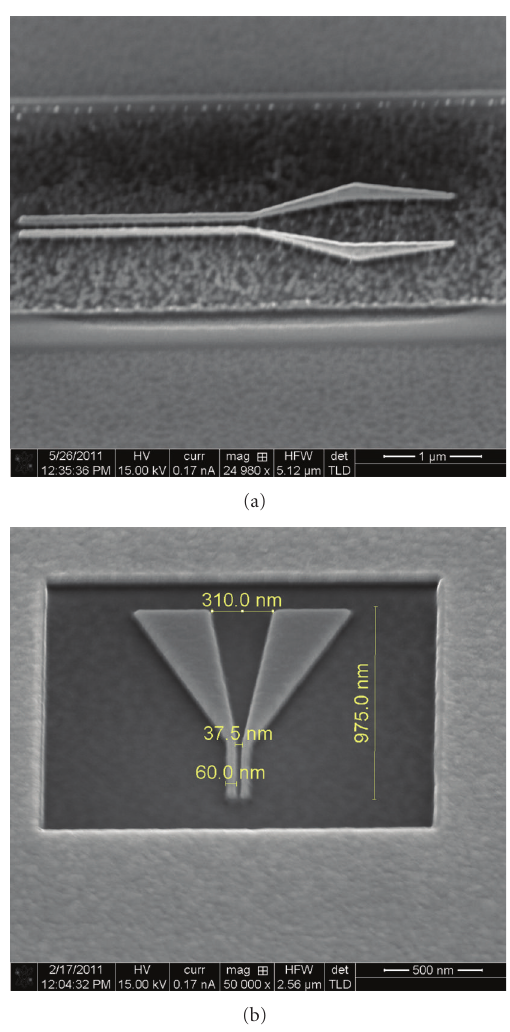
Figure 12: Example of gold nanoantennas fabricated using dual beam focused ion beam (FIB) milling. Nanoantennas were fabri- cated in 50 nm gold on thick glass